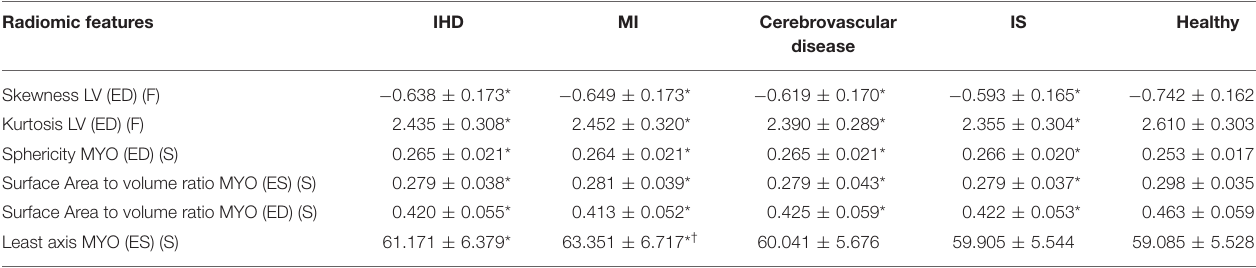
TABLE 5 | Selected radiomic features for each disease group compared to healthy